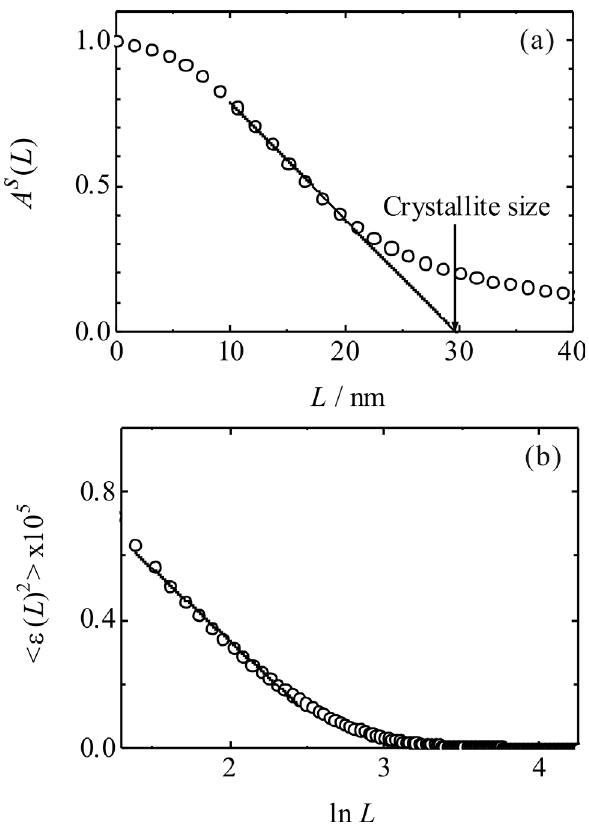
Figure 2: (a) Size component of Fourier coefficient A s ( L ) and D E (b) mean-square strain " ð L Þ 2 of the copper at a cold rolling of 75%